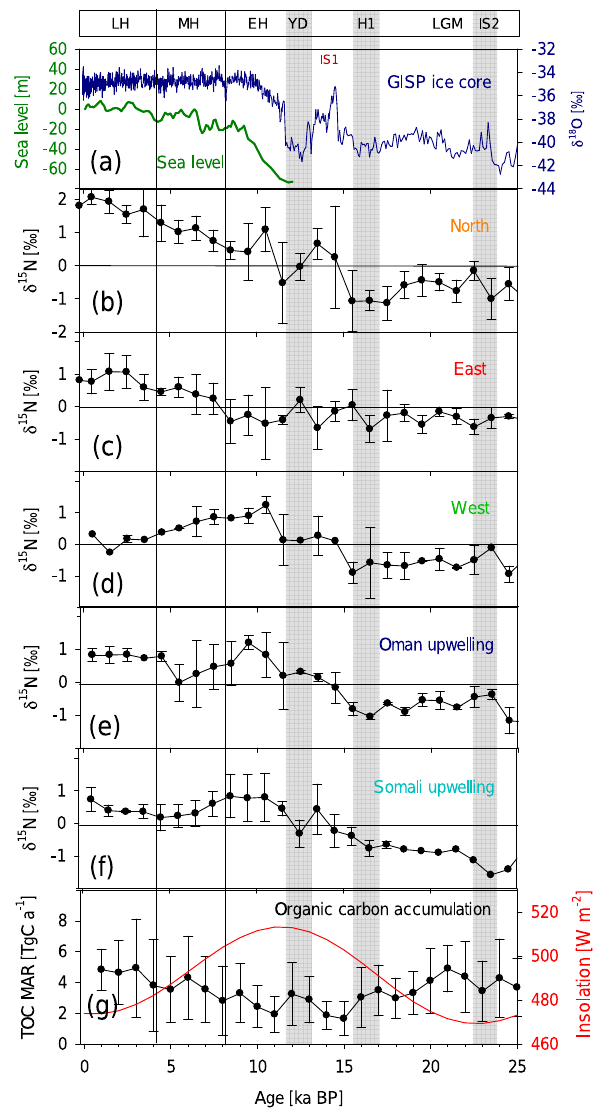
Figure 6. The δ 18 O values in ‰ from the GISP2 ice core (Grootes and Stuiver, 1997) and sea level (m above NN) reconstruction from the Red Sea (Siddall et al., 2003) (a) compared with millennial regional averages of normalized and averaged δ 15 N (‰) values from the northern (b) , eastern (c) , and western (d) Arabian Sea, the Oman (e) , and Somali (f) upwelling area. Total organic carbon mass accumulation in the Arabian Sea (TOC MAR in TgCyear − 1 ; data from Cartapanis et al., 2016, and Tim Rixen, unpublished) and insolation at 30 ◦ N in Wm − 2 (Berger and Loutre, 1991) (g) during the last 25kyr. Error bars denote ± 1 σ . Grey bars and abbreviations as in Fig. 3; interstadial 1